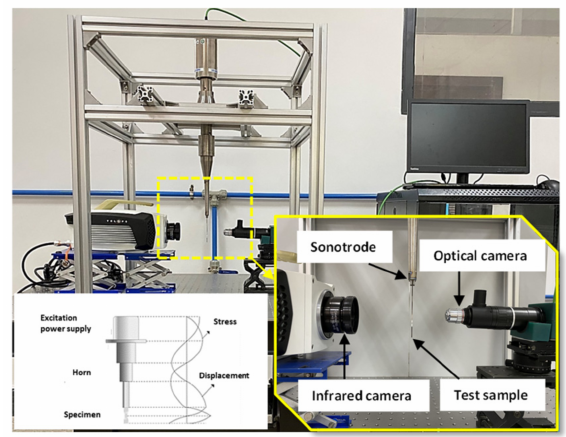
Figure 1. In situ ultrasonic fatigue test machine.